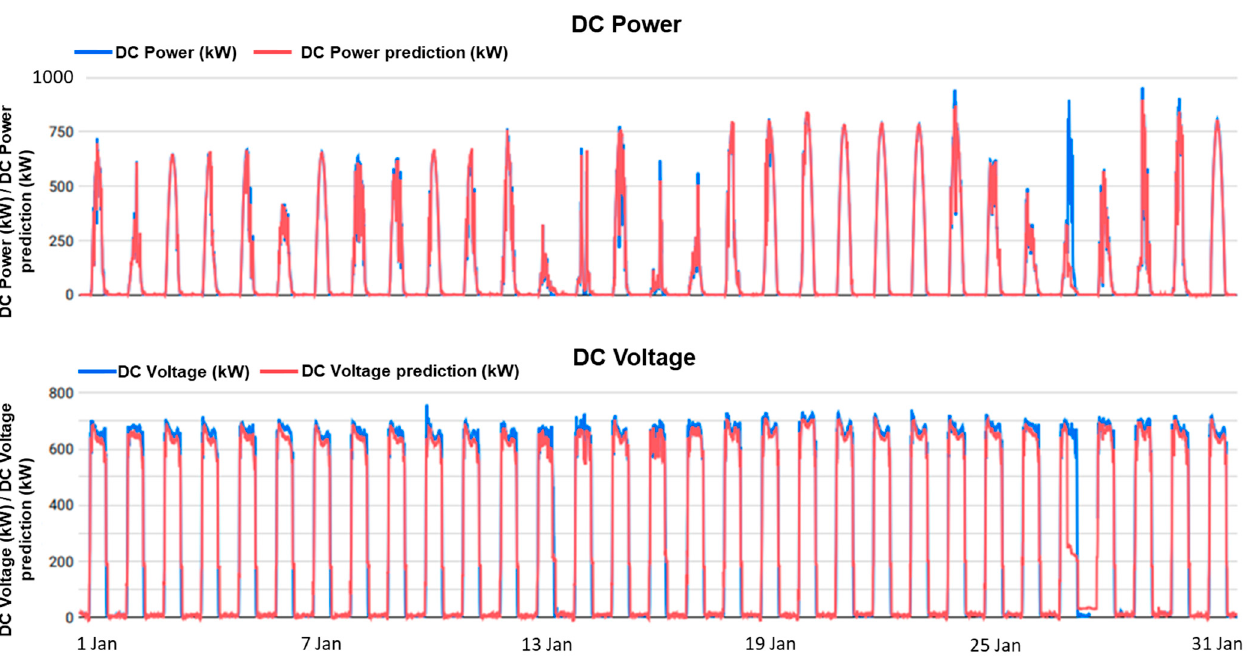
Figure 10. Measured (blue lines) and predicted (red lines) DC power and voltage in January 2021.